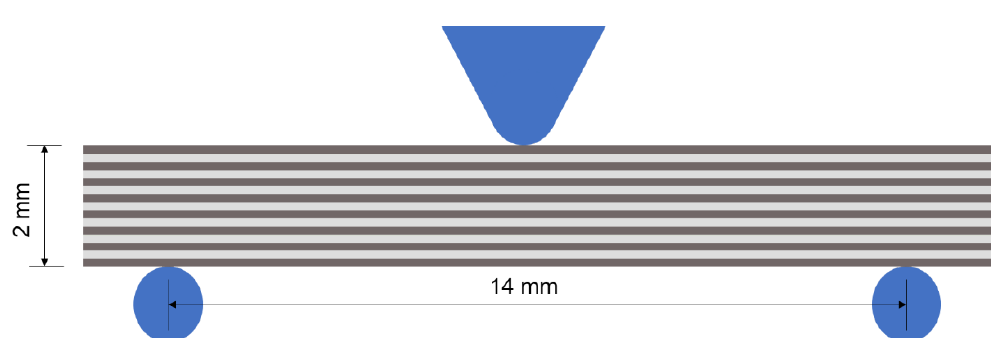
Figure 2. Schematic diagram of three-point bending test. The testing span is 14 mm and the height and width are 2 mm.